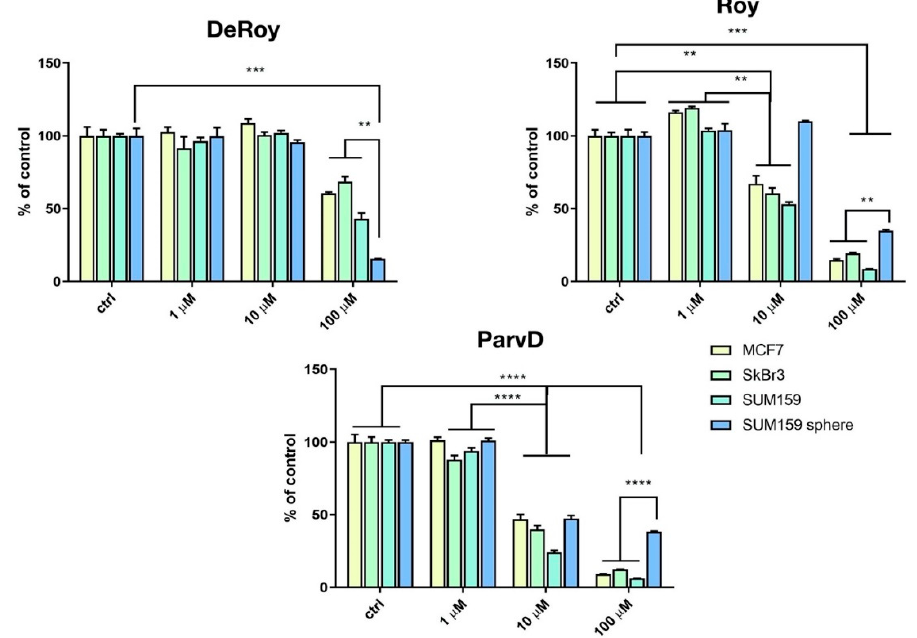
Figure 3. Cytotoxicity activity (MTT assay) on MCF-7 (hormone-positive breast cancer cells), SkBr3 Her-positive, SUM159 triple-negative, and SUM159 spheres. Statistical significance between marked groups: ** p < 0.01, *** p < 0.001, **** p < 0.0001.